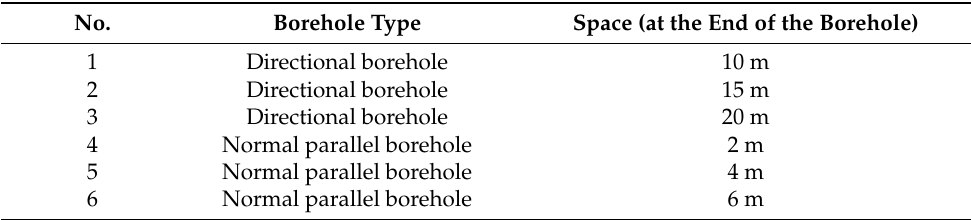
Figure 2. Gas drainage boreholes—directional borehole and normal parallel borehole. Table 3. Simulation scenarios for different boreholes.